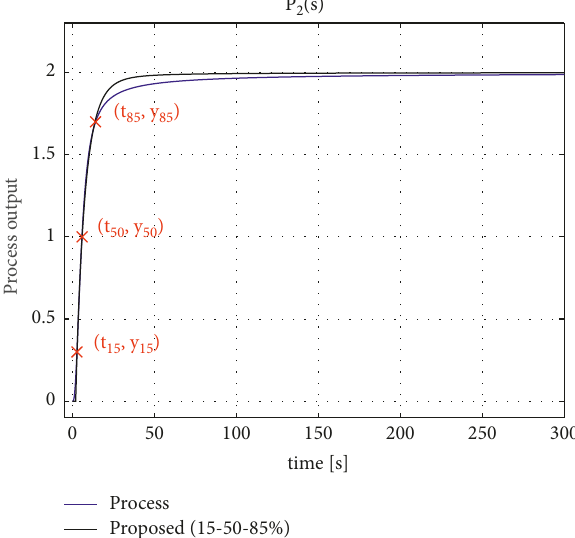
Figure 16: Process reaction curve and FFOPDT model method # 1 (5–50–95%) step response for process P 2 .